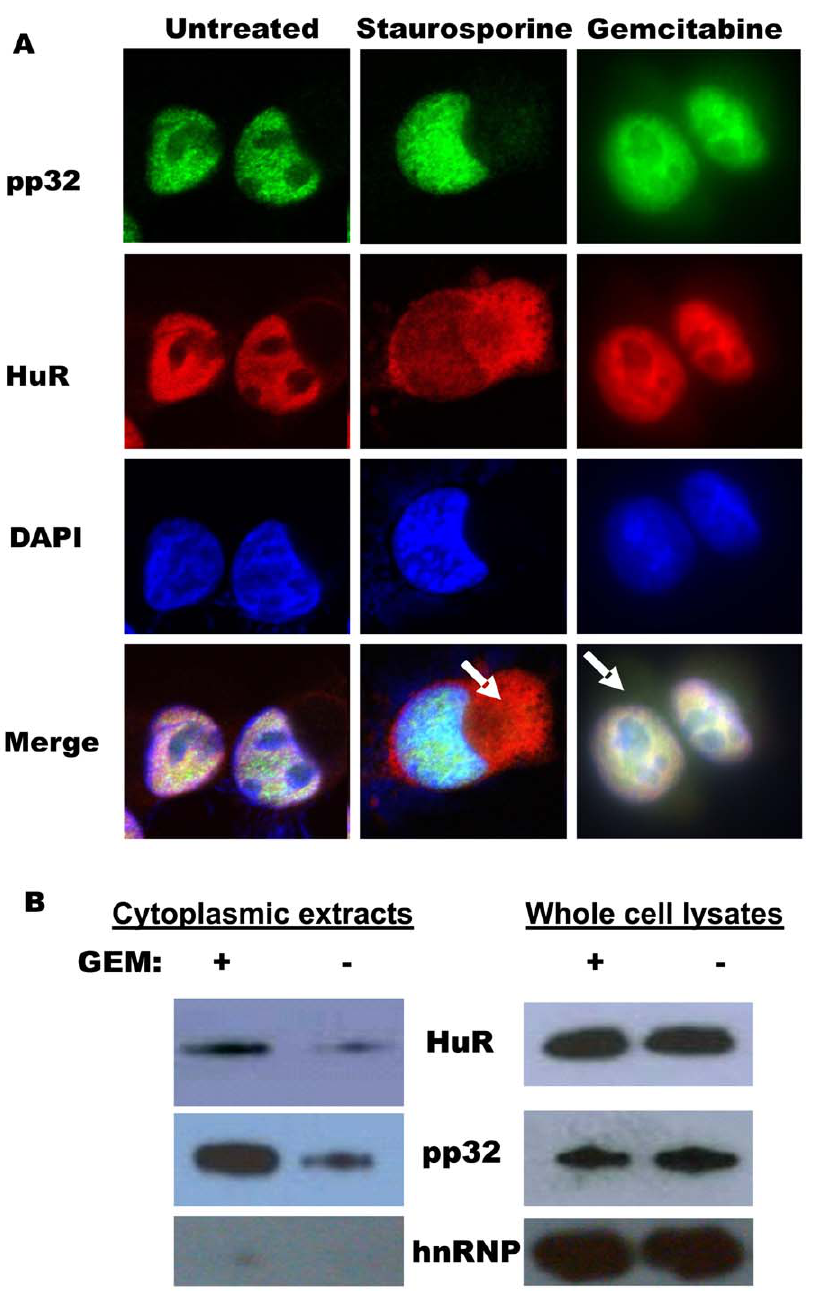
Figure 5. Subcellular localization of pp32 and HuR levels and sensitivity to stressors. (A) Immunofluoresence showing increased HuR and pp32 cytoplasmic expression in cells treated with STS (1 m M for 3 h) and GEM (1 m M for 3 h), as indicated by the white arrows. (B)Immunoblot analysis of HuR and pp32 levels in cytoplasmic and whole-cell lysates prepared from cells that were treated as explained in (Figure 5).